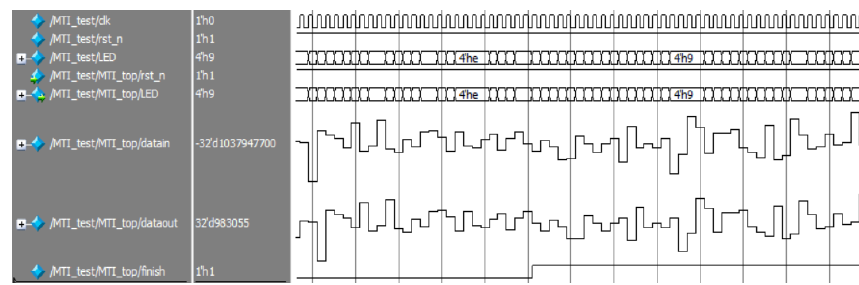
Figure 15. Moving target detection before filtering.